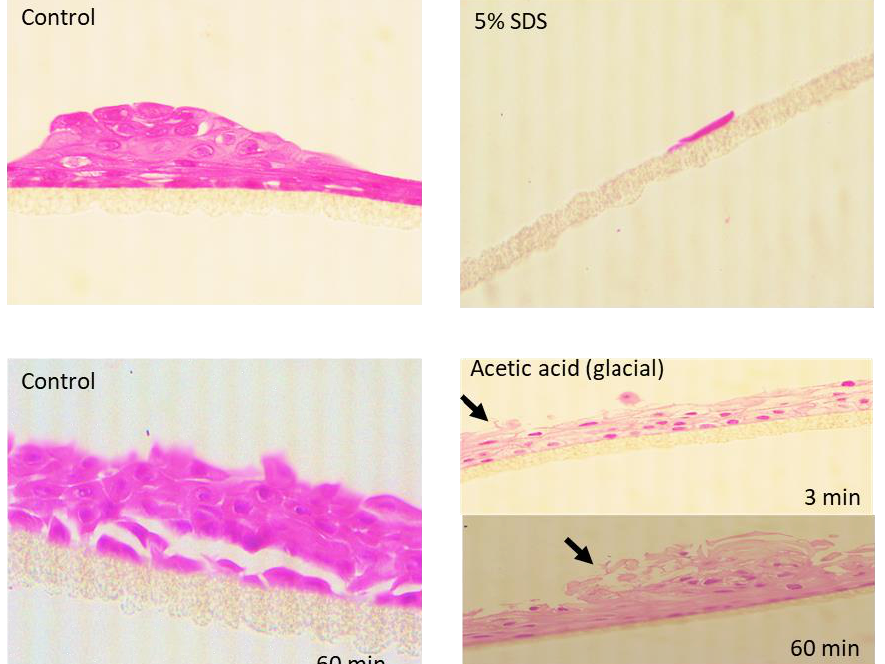
Figure 4. Micrographs of sections of the cEpiderm untreated (Control) and upon irritation (5% SDS) or corrosion (acetic acid) insult. Arrows point to tissue disruption.